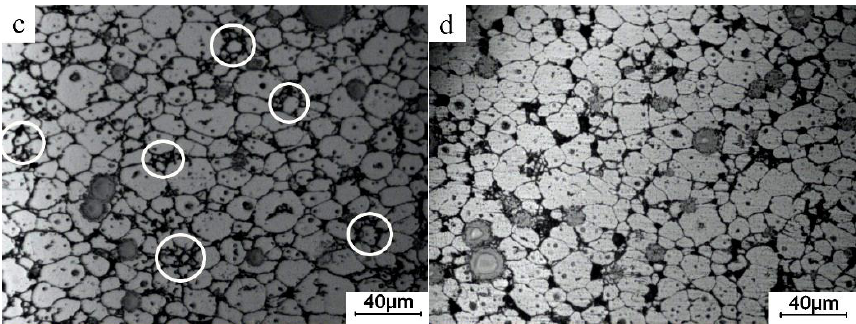
Figure 6. OM micrographs of the mixed powder bulk alloy heated at 640 °C for different lengths of time and then water-quenched. ( a ) 15 min; ( b ) 25 min; ( c ) 60 min; ( d ) 210 min.